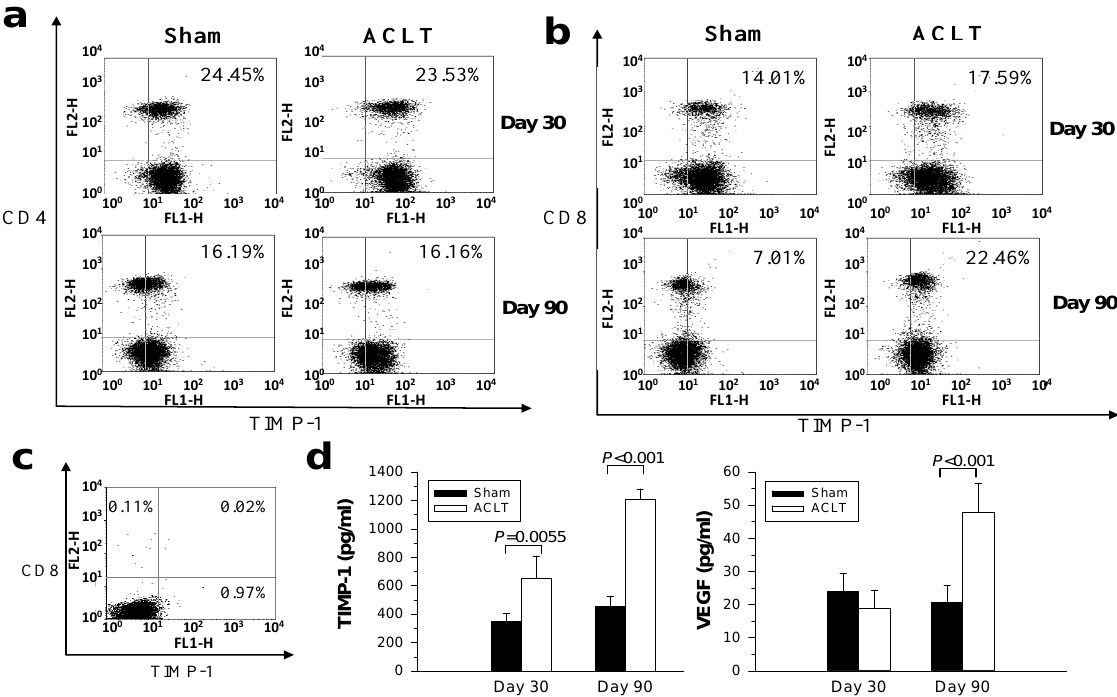
Figure 4. TIMP-1-expressing T cells in spleens and tissue after OA induction. Intracellular flow cytometry of TIMP-1 in splenocytes 30 days and 90 days after OA induction ( n = 6 per group). The cells were double-stained with ( a ) CD4 and TIMP-1 markers; or ( b ) CD8 and TIMP-1 markers. Representative data in each group are shown; ( c ) Cells stained with secondary antibodies only. Results are representative of two